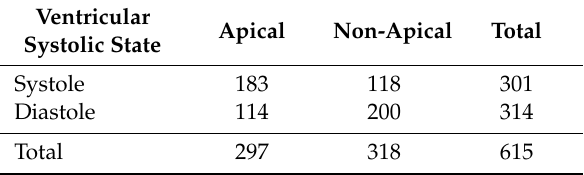
Table 1. Distribution of test data classified by cardiac axis orientation and ventricular systolic state. Ventricular Apical Non-Apical Systolic State